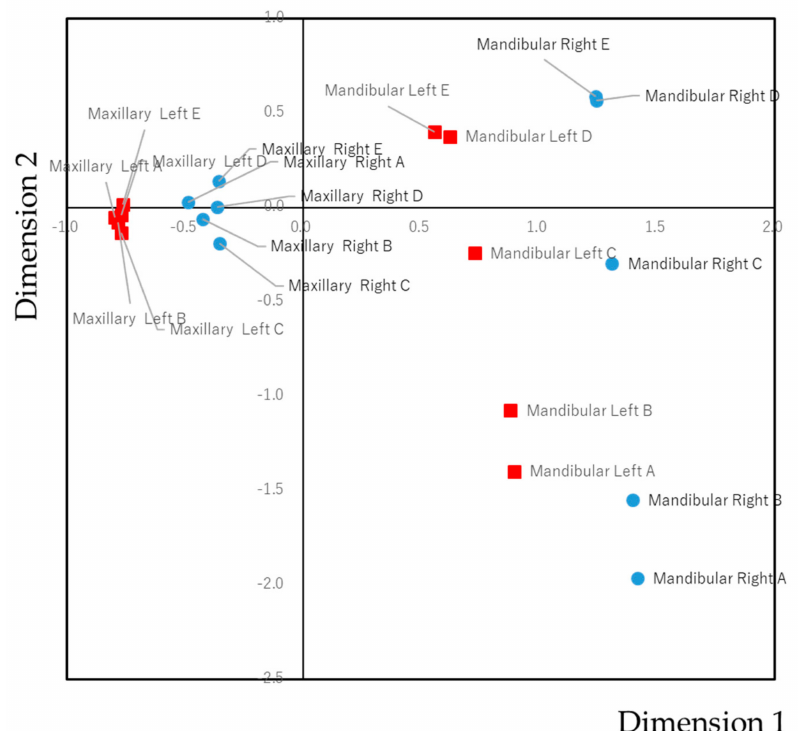
Figure 3. Biplot of the susceptibility of dental caries. The biplot graphically shows the correlations between multiple categorical variables. Items that had a strong correlation are closely located in the biplot. In this case, primary teeth with a high co-prevalence of dental caries in primary dentition are located